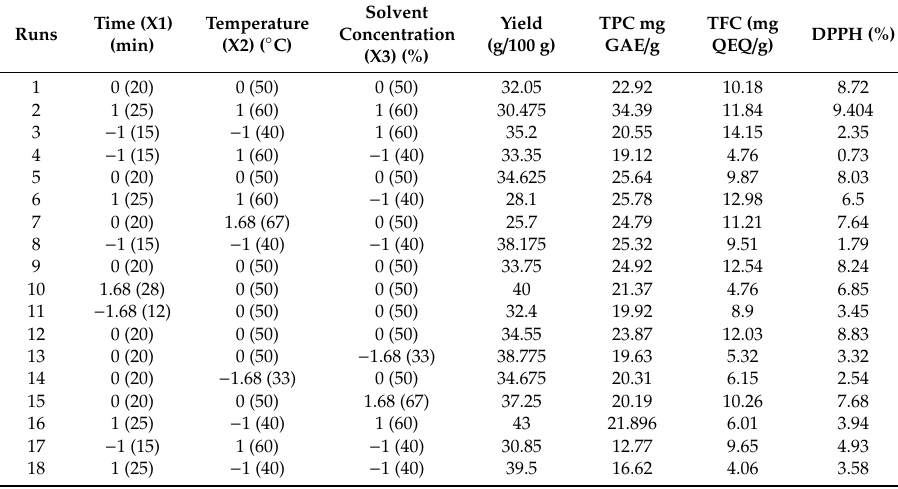
Table 2. Three-factor, five-level central composite design used for the extraction of total phenolic content (TPC), total flavonoids content (TFC), and antioxidant activity of extracts. GAE / g: gallic acid equivalent per gram, QEQ / g: quercetin equivalents per